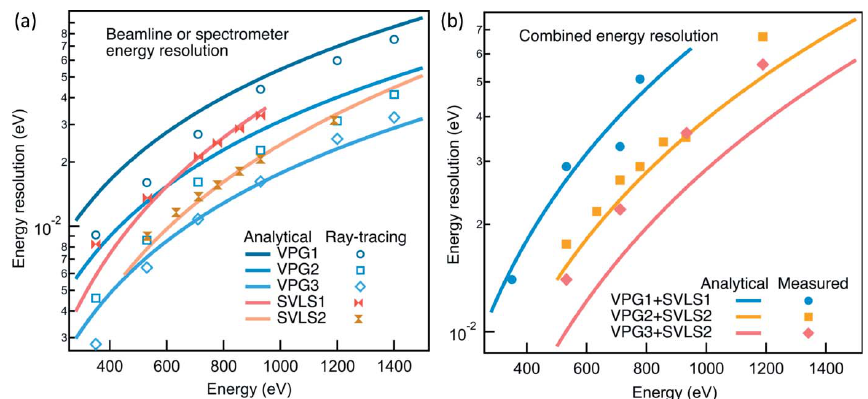
Figure 2 I21’s energy resolution. ( a ) The analytical and ray-traced energy resolution of the beamline and the RIXS spectrometer. ( b ) The analytical combined energy resolution with the experimental data.